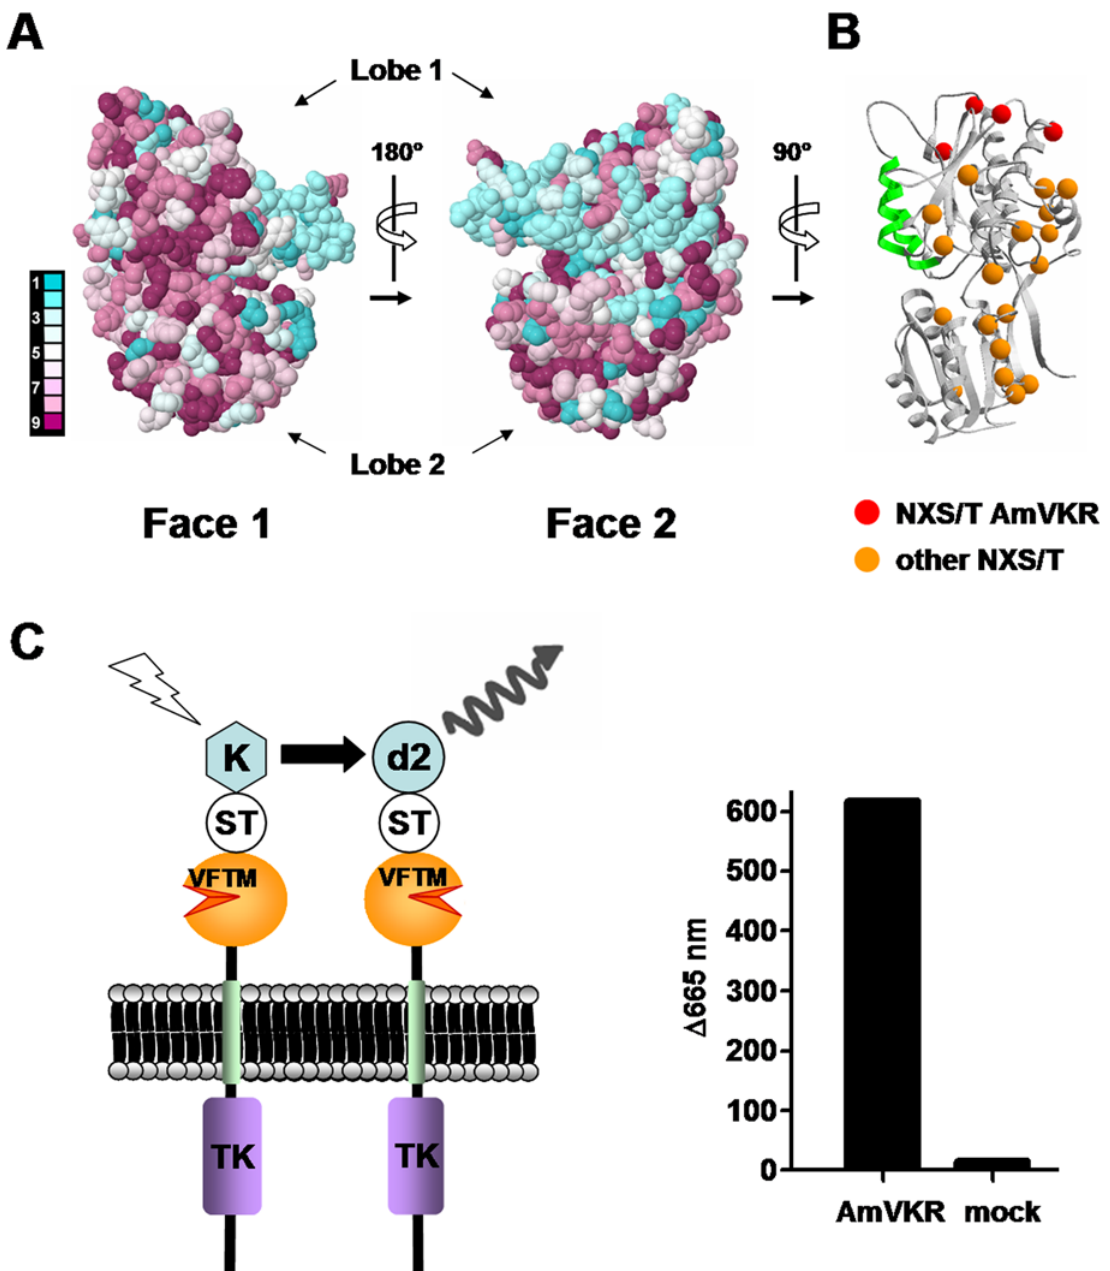
Figure 8. VKR can form dimers. A- Evolutionary conservation of residues at the surface of all VKR VFTMs visualized on both faces of the VFTs (Face 1 and Face 2) using the tridimensional model of AmVKR. Conservation scores are according to a color scale from variable (blue) to conserved (purple) residues. B- Ribbon view of the AmVKR VFTM is shown, with the putative N-glycosylation sites (C- a of Asn residue) found in AmVKR (in red) and in all described VKRs (in orange). C- Time-resolved FRET signal measured between snap-tag (ST) labeled AmVKR subunits at cell